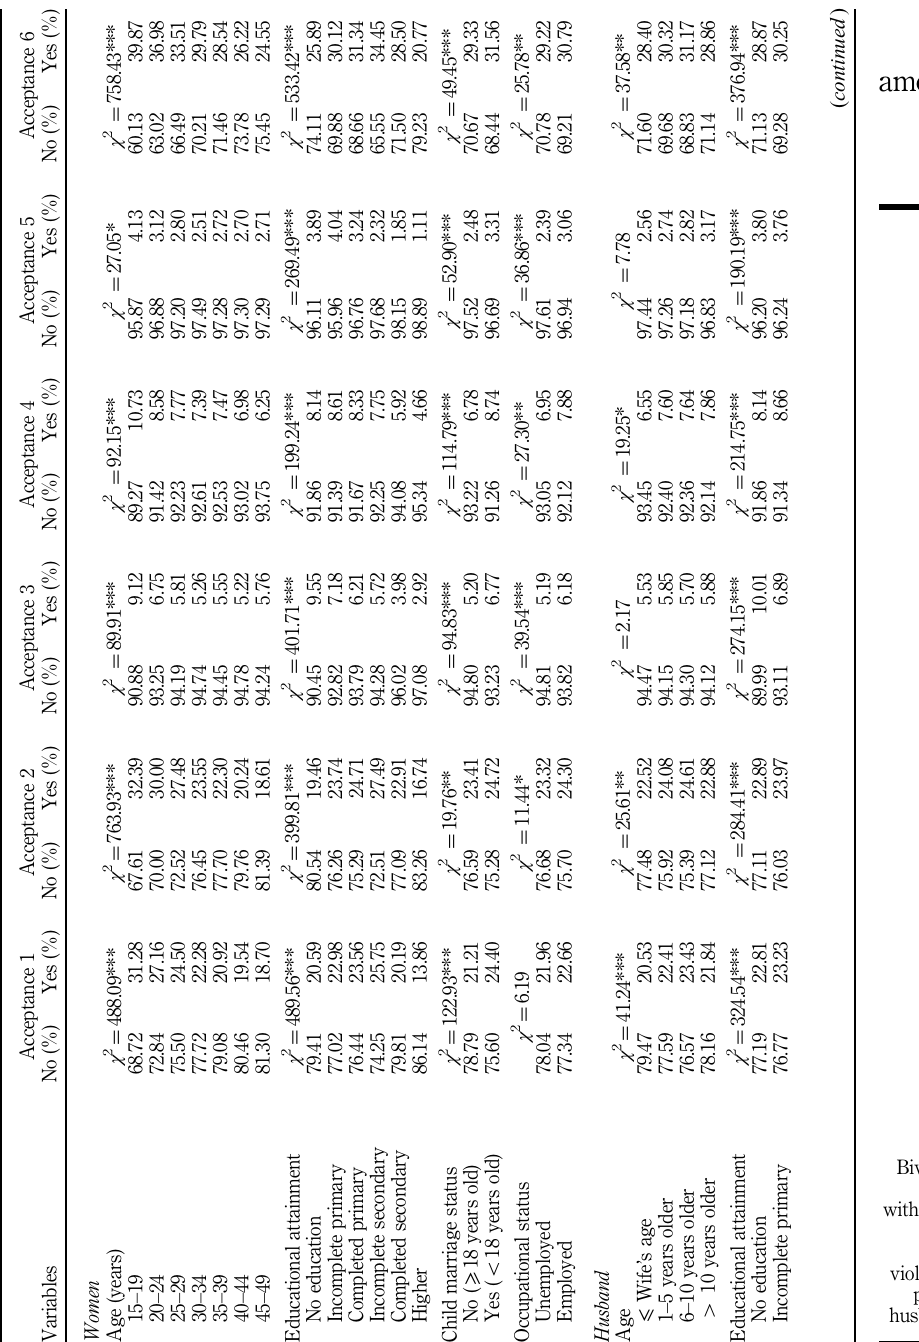
Table II. Bivariate analysis